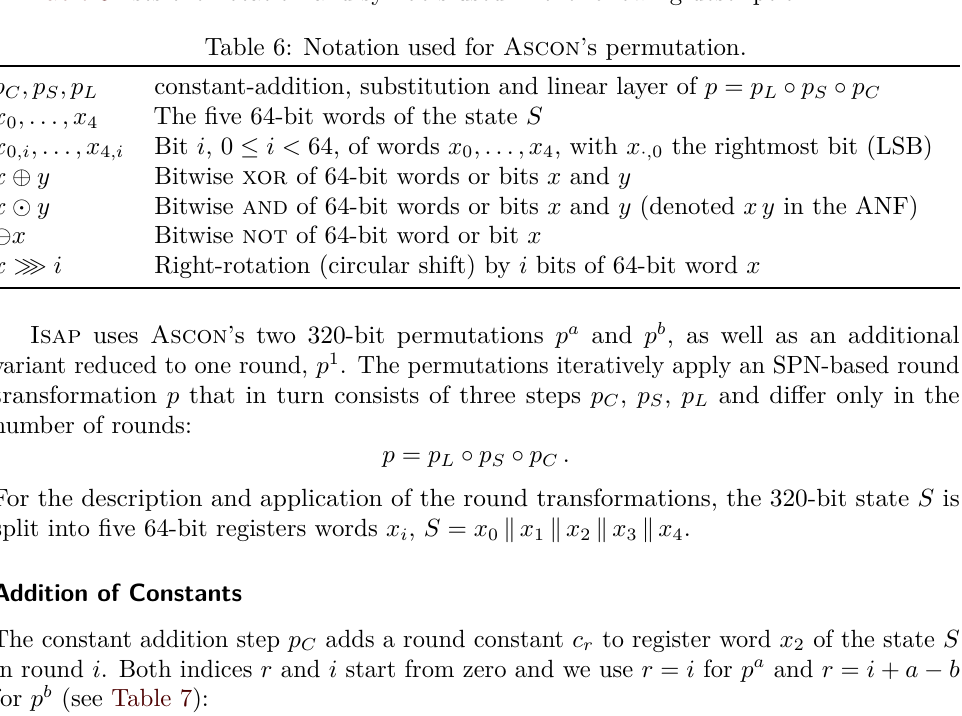
Table 7: The round constants c